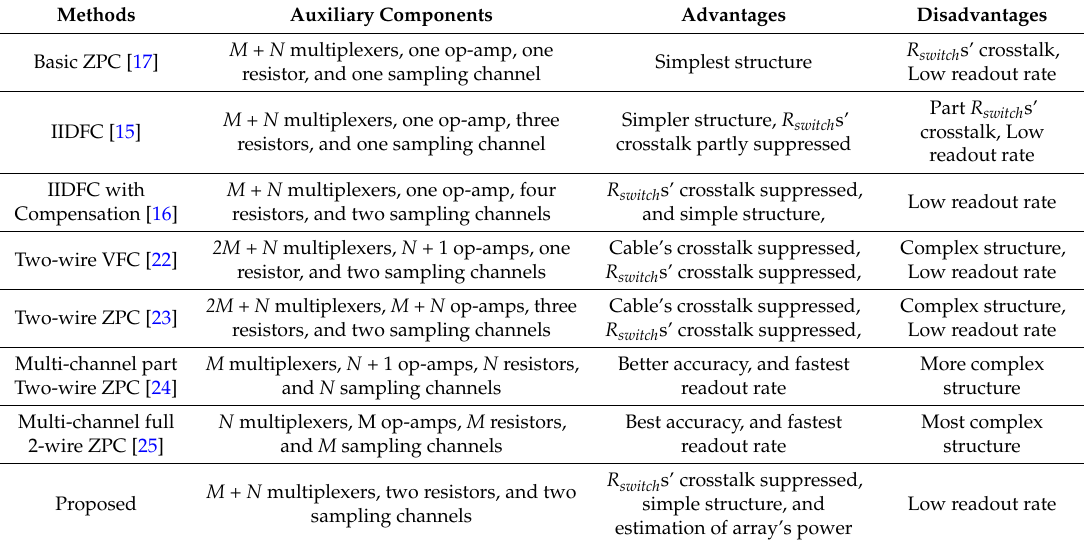
Table 1. Comparison of ZPCs and VFCs of the M × N resistive sensor